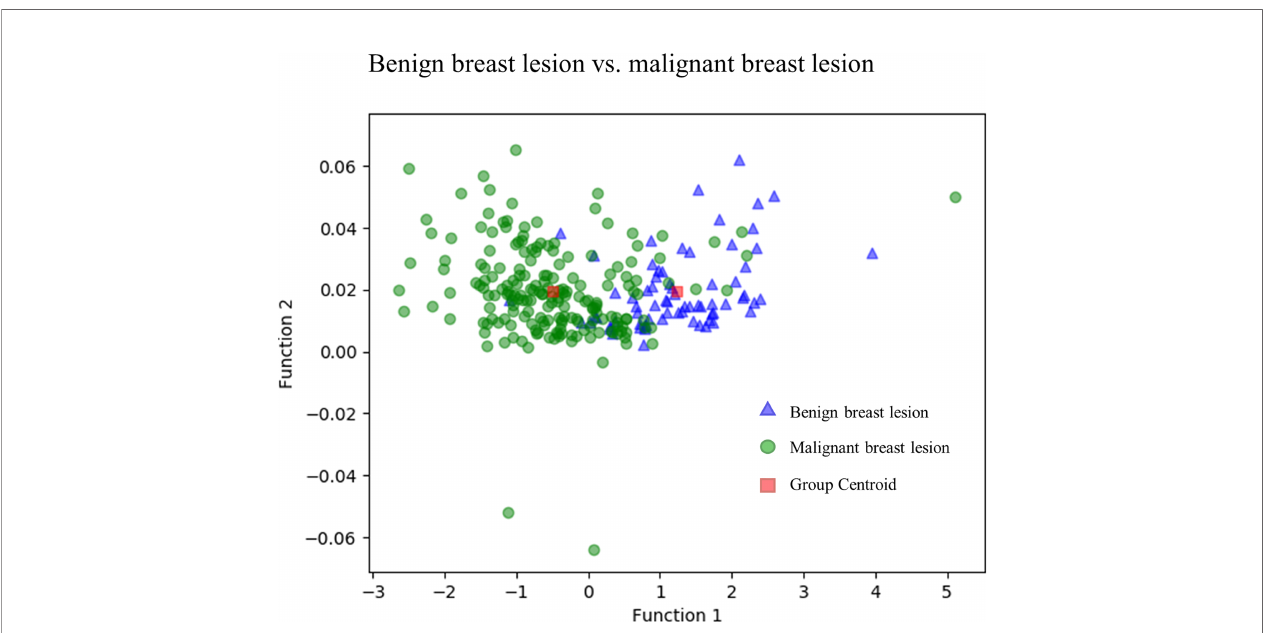
FIGURE 3 | Discriminative function of the GBDT + LDA models. Distribution of the benign and malignant breast lesions that originated from multiple dimensions were reduced and re fl ected to a two-dimension plane. Little overlap was observed between the distribution of benign breast lesion groups (triangles) and malignant breast lesion groups (circles) and the distribution of group centroids (squares). It suggests a qualitative separation between benign and malignant breast lesions. GBDT, gradient boosting decision tree; LDA, linear discriminant